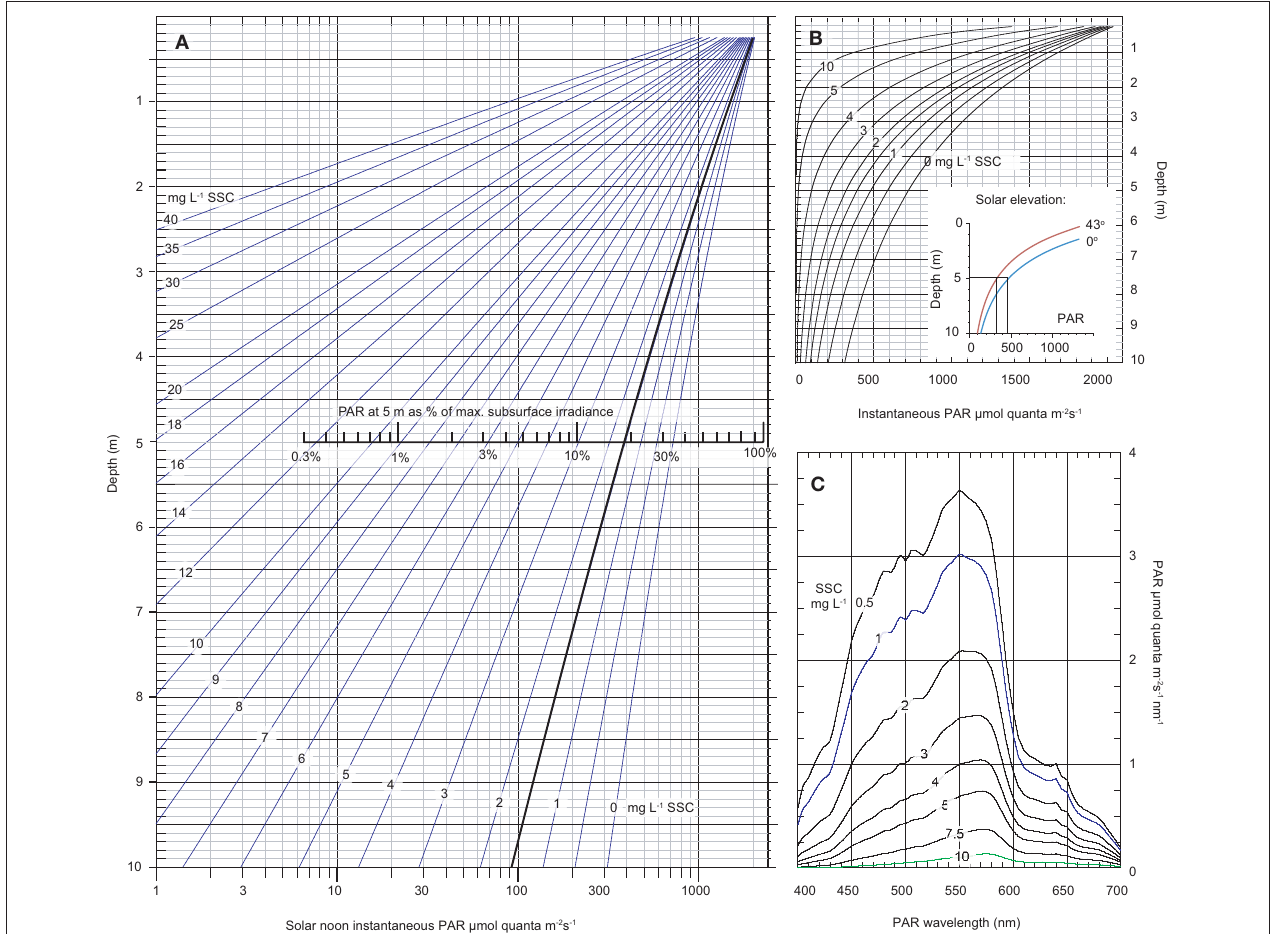
FIGURE 8 | Modelled data based on the empirical spectral solar irradiance model derived from the plume profiling exercise showing (A) an optical nomograph of maximum instantaneous PAR (400–700nm) in µ mol quanta m − 2 s − 1 (x-axis, log scale) and as a % of maximum subsurface irradiance, from 0.25–10m water depth (y-axis) under a range of SSCs from 0–40mg L − 1 and a solar elevation angle of 0 ◦ from vertical (i.e., sun directly overhead), and a cloud-free day, (B) the same data as (A) but without a log scale with the inset figure showing modelled underwater light levels at 1.5mg L − 1 but under a solar elevation of 0 or 43 ◦ from vertical (see text), (C) modelled spectral profiles in µ mol quanta m − 2 s − 1 nm at 5m depth under a range of SSCs from 0.5–10mg L − 1 at a solar elevation angle of 0 ◦ from vertical and a cloud-free